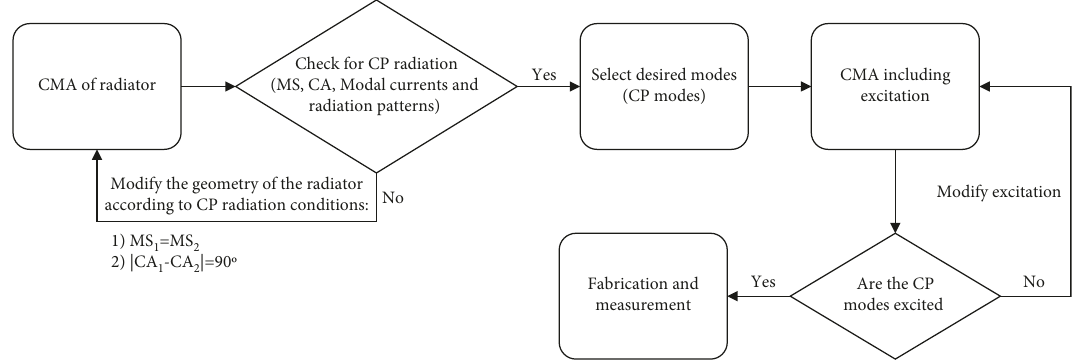
Figure 1: Flowchart outlining design process.